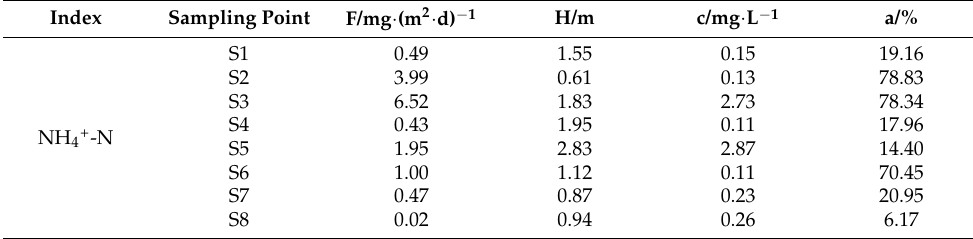
Table 8. Contribution rate of NH 4+ -N nutrient diffusion at the sediment–water interface to the water body.